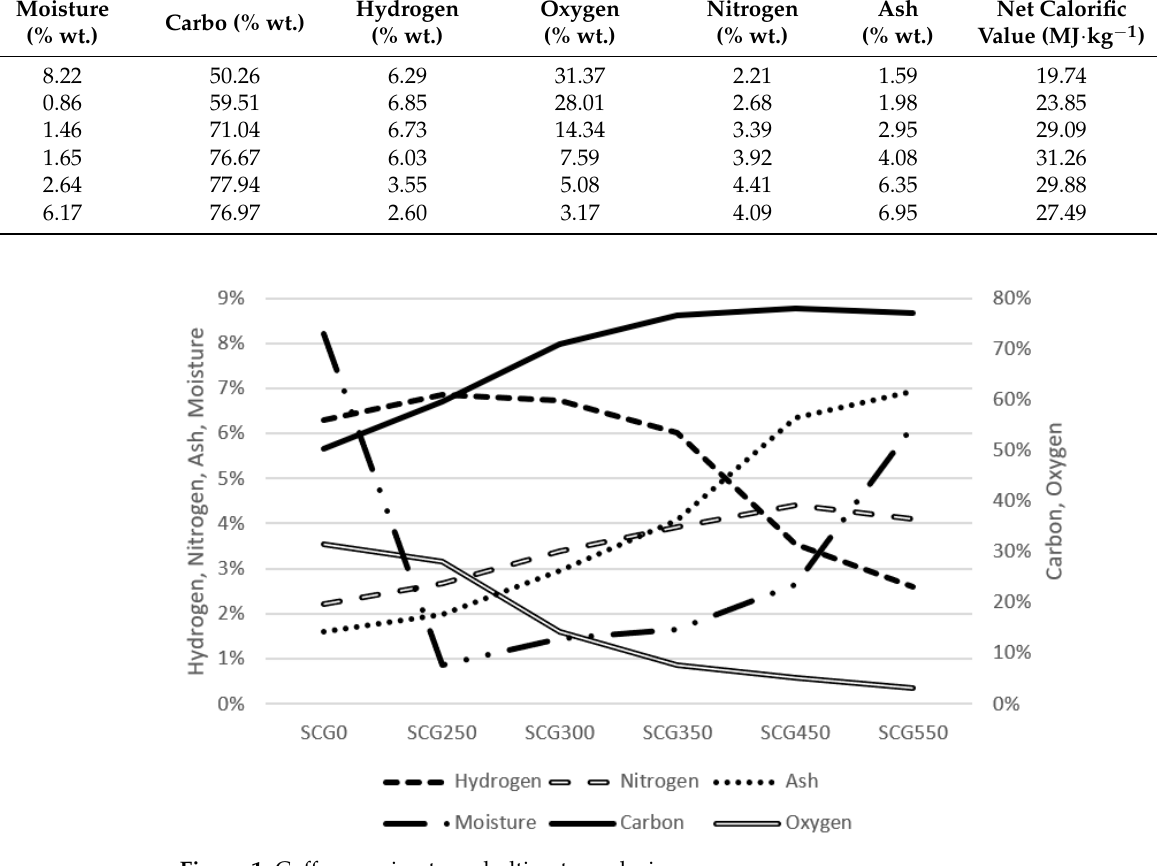
Figure 1. Coffee proximate and ultimate analysis.